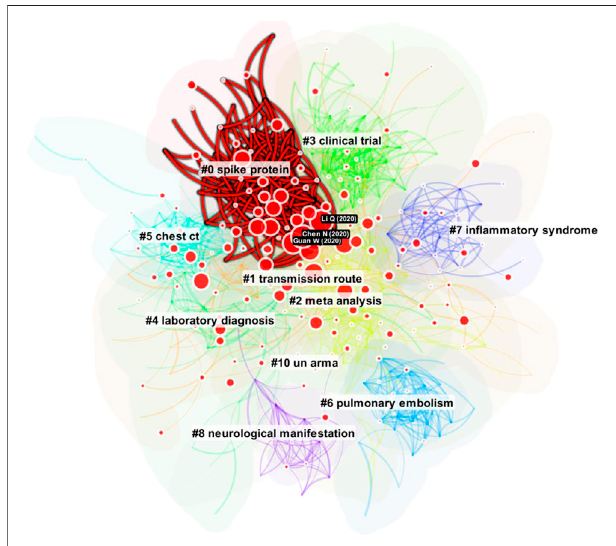
FIGURE 8 | References associated with the strongest sentiment of uncertainty are from Cluster #0 spike protein.